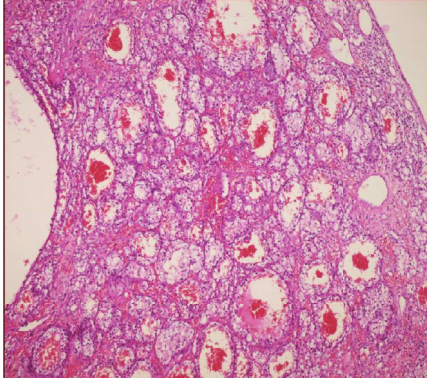
Figure 2: Dilated blood vessels and cells clusters with clear cyto- plasm in congested loose stroma (H&E, × 20).